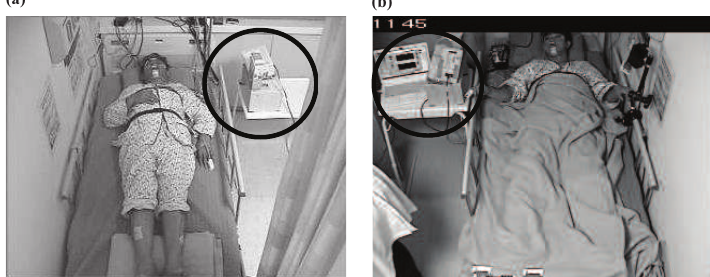
Figure 7. The experimental environment at Hanyang University Hospital: ( a ) Room A; ( b ) Room